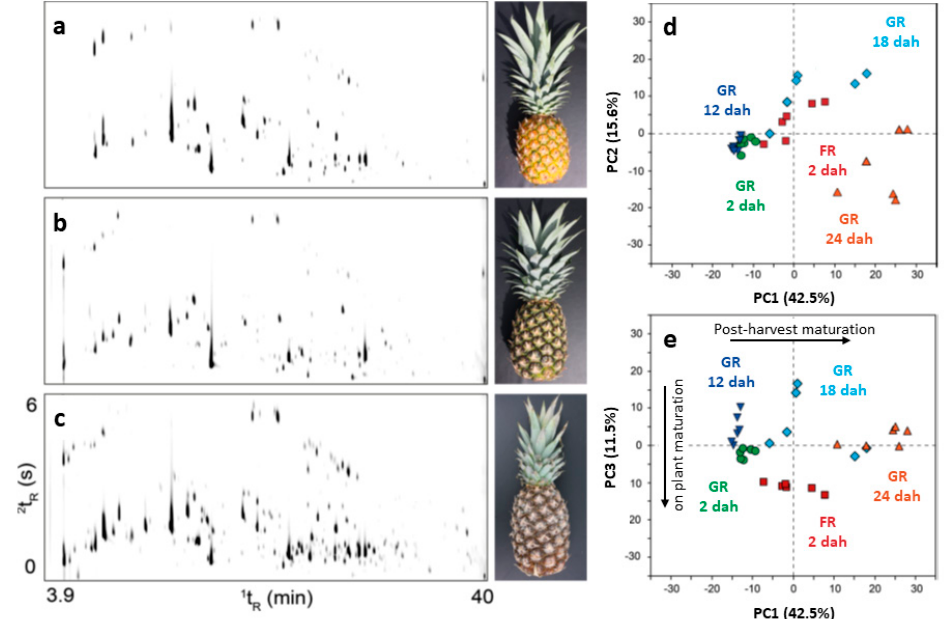
Figure 2. Pineapple volatile profiles (GC × GC-quadrupole MS (qMS)) at di ff erent ripening stages: ( a ) FR 2 dah; ( b ) GR 2 dah; and ( c ) GR 24 dah. Principal component analysis score plots ( d ) PC1 × PC2 and ( e ) PC1 × PC3. GR: green-ripe; FR: fully ripe; dah: days after harvest. PC1: postharvest maturation; PC2: late postharvest maturity stages of sea-freighted pineapples; PC3: plant ripened pineapples. Source: adapted with permission from Steingass et al. [27].